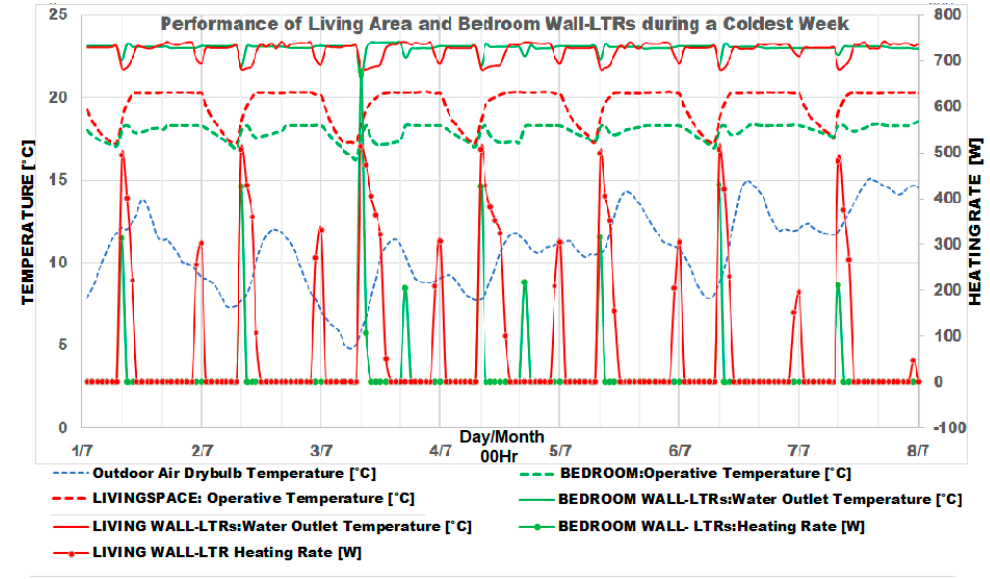
Figure 6. Living area and bedroom temperatures and heating rates of LTRs in the coldest week.